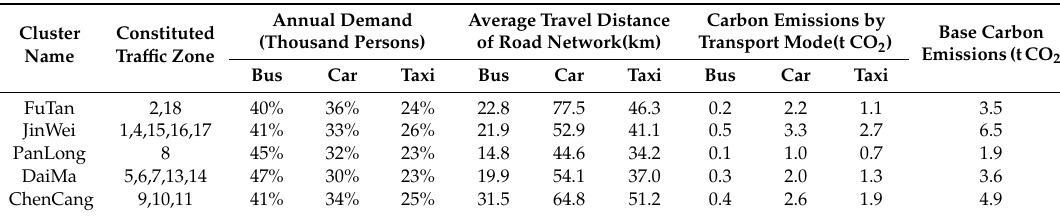
Table 5. Annual carbon emissions under the baseline scenario in Baoji, 2023, showing tra ffi c cluster